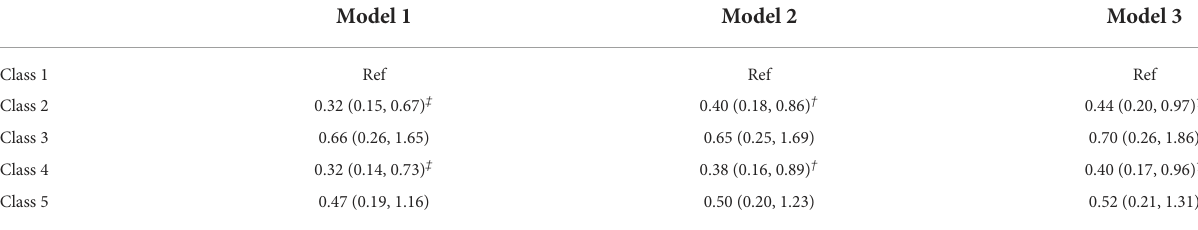
TABLE 3 Associations between possible sarcopenia and depression in individuals and their